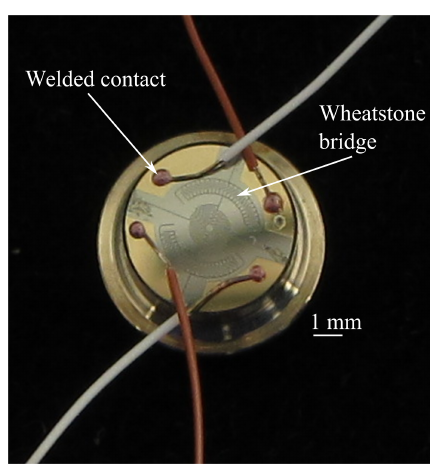
Figure 5. Laser-welded Cu wires ensure the electrical contacts to the Wheatstone bridge on the steel membrane.